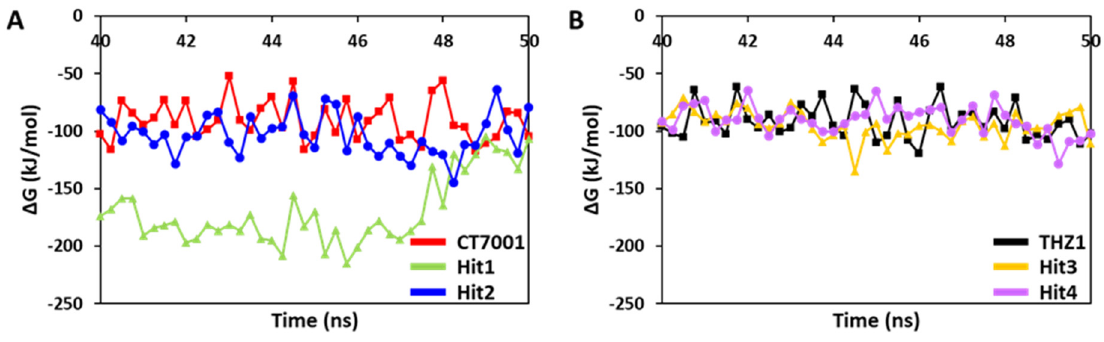
Figure 7. Binding free energy ( ∆ G) analysis for ( A ) CT7001, Hit1, and Hit2, and ( B ) THZ1, Hit3, and Hit4. Table 4. The distribution of the total binding free energy scores for reference inhibitors and identified hits with CDK7 calculated through MM-PBSA